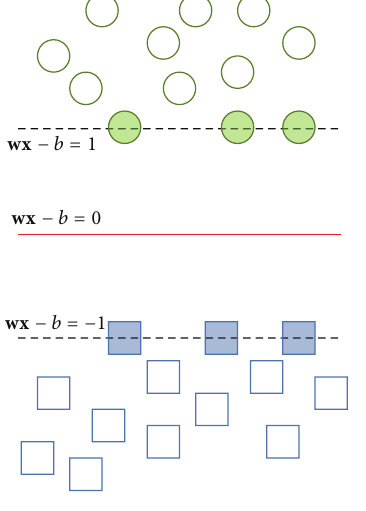
Figure 4: The concept of parallel